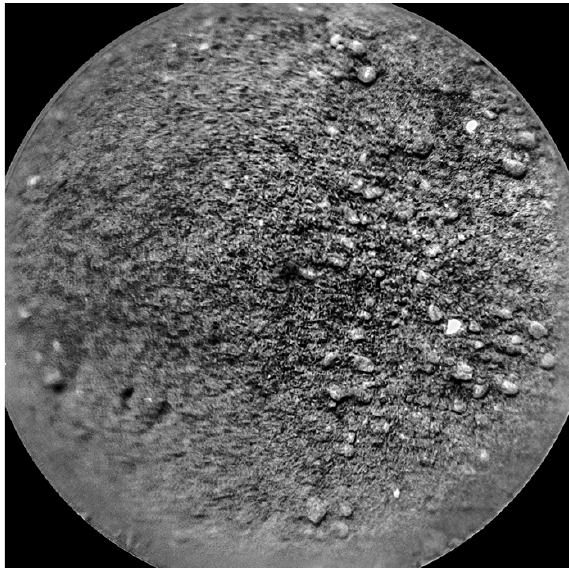
Figure 7 An example of 1.75x ChemCam SRR produced from 16 input images.